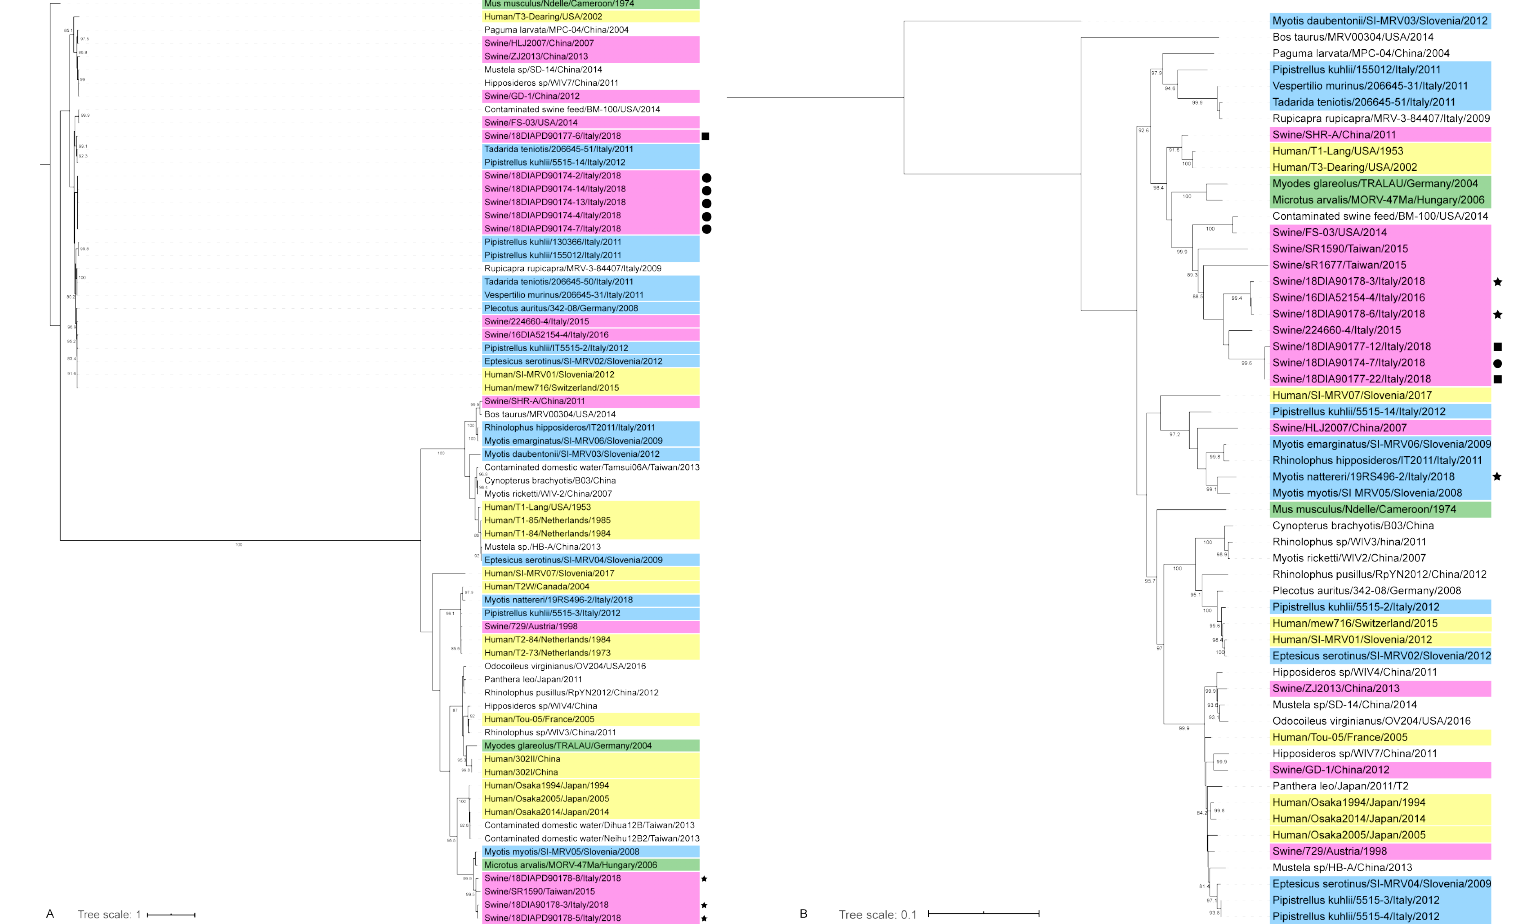
Figure 4. Phylogenetic tree of mammalian orthoreoviruses based on complete S1 ( A ) and L1 ( B ) segments. Bootstrap values >80 are not shown. Sequences are coloured based on the host species, with original sequences marked according to the farm of